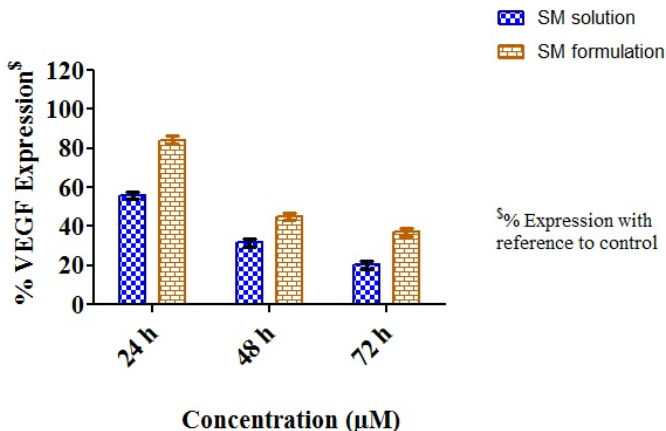
Figure 6. Percent vascular endothelial growth factor (VEGF) expression in ARPE-19 cells treated with the sunitinib drug solution and the MPEG-PCL formulation at 24, 48, and 72 h using ELISA (mean ± SD, n = 4).